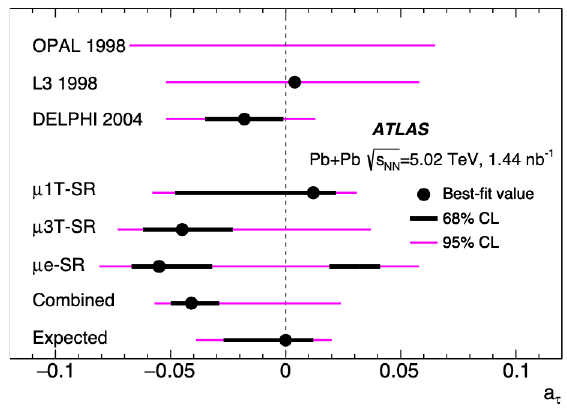
Figure 10. Measurements of a τ from fits to individual signal regions (including the dimuon control region), and from the combined fit. These are compared with existing measurements from the OPAL, L3 and DELPHI experiments at LEP. A point denotes the best-fit a τ value for each measurement if available, while thick black (thin magenta) lines show 68% CL (95% CL) intervals. The expected interval from the ATLAS combined fit is also shown